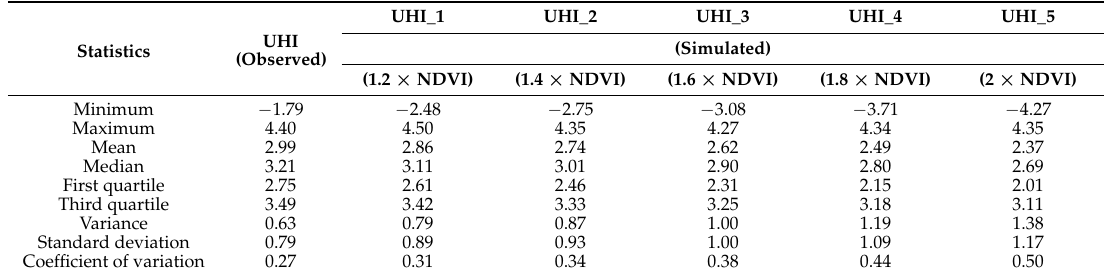
Table 4. Simulated UHI intensity statistics with NDVI